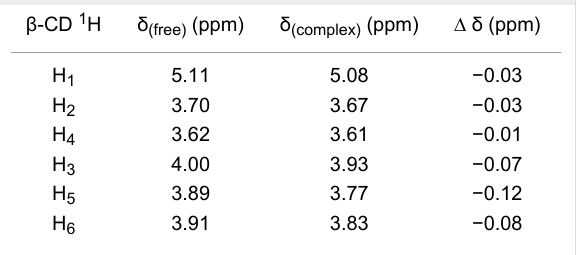
Table 3: 1 H NMR chemical shifts ( δ , ppm) for free β -CD and β -CD/ trans -Ner inclusion complex solutions in D 2 O in the presence of 0.5 mM β -CD and 3.28 mM trans